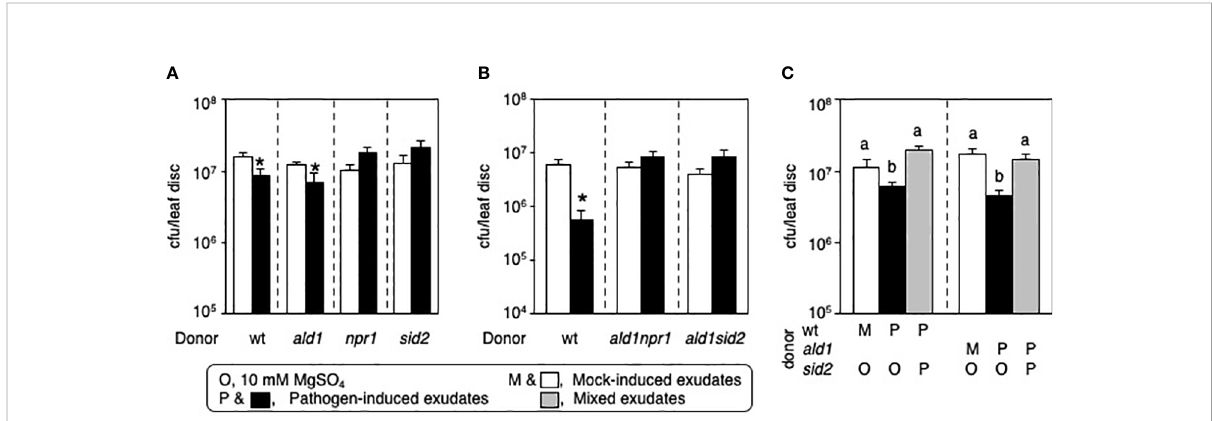
FIGURE 5 NPR1 and SID2 are needed to make active exudates capable of inducing disease resistance in plants. (A) Bacterial growth in the recipient WT plants pre-immunized with mock-induced exudates (MEX, white boxes) and pathogen-induced exudates (PEX, black boxes) from WT, ald1 , npr1 , and sid2 plants. (B) Biological activity of PEXs collected from ald1npr1 and ald1sid2 double mutants. (C) Inhibitory effect of PEX from sid2 mutant on active PEXs collected from WT and ald1 infected with SAR-inducing Psm ES4326/ AvrRpt2 . Mixed exudates were pre-applied into the leaves of recipient WT plants prior to challenge-inoculation. m, mock-induced exudates; p, pathogen-induced exudates. Data represent the averages with standard errors. The asterisks ( p < 0.05, two-tailed Student ’ s t-test, n = 8) and different letters ( p < 0.05, one-way ANOVA, n = 8) indicate statistically signi fi cant differences. The experiments were repeated at least twice with similar